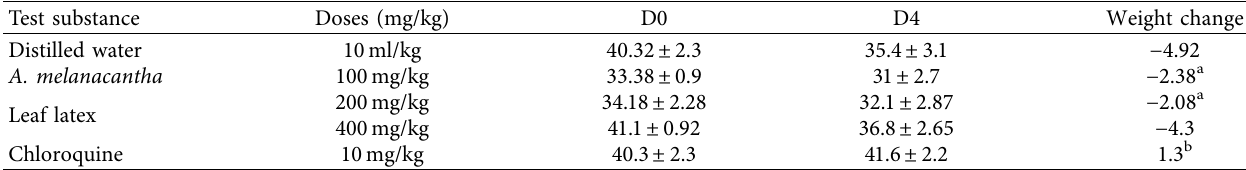
Table 3: Effect of A. melanacantha leaf latex on body weight of Plasmodium berghei infected mice.